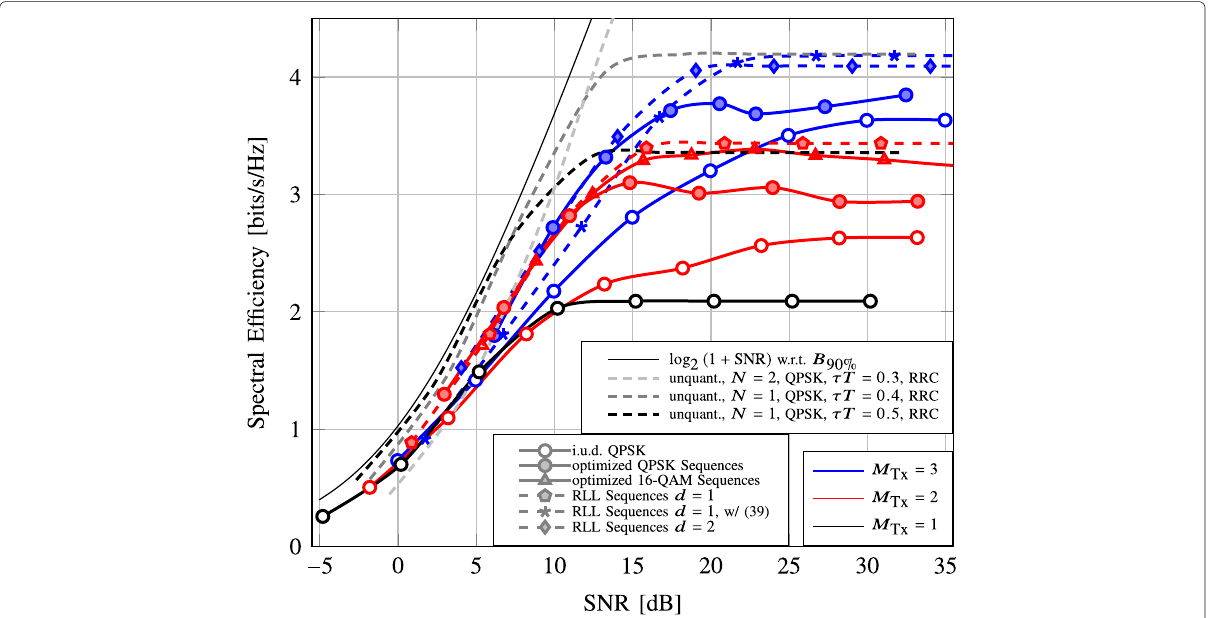
Fig. 17 Spectral efficiency ( B 90% ) versus SNR, with FTN signaling, M =